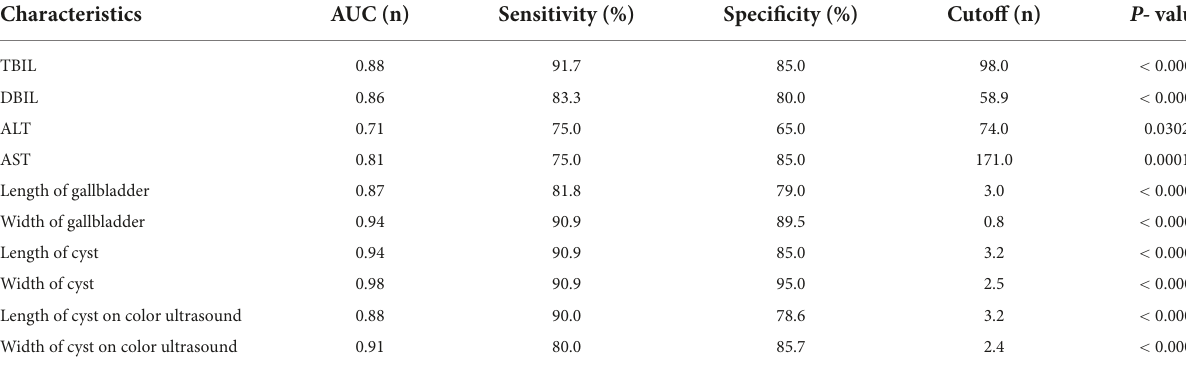
TABLE 3 Differences in the diagnostic performance of parameters.